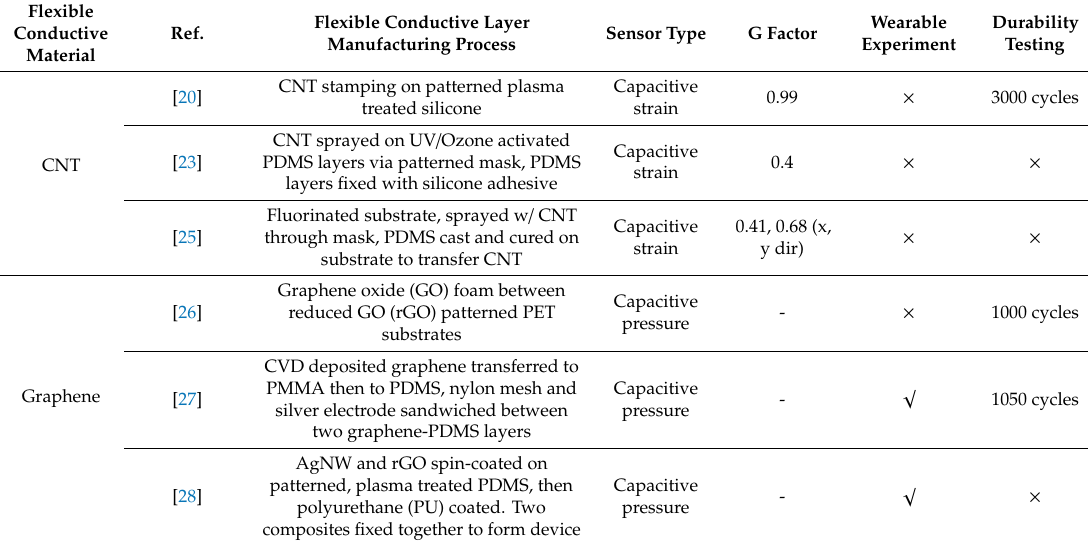
CNT sprayed on UV / Ozone activated PDMS layers via patterned mask, PDMS layers fixed with silicone